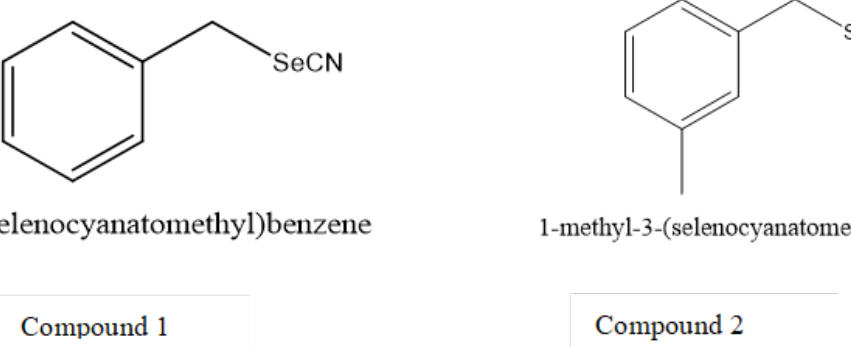
Figure 1. Chemical structures of selenocyanates employed in the selected chemogenetic profiling.